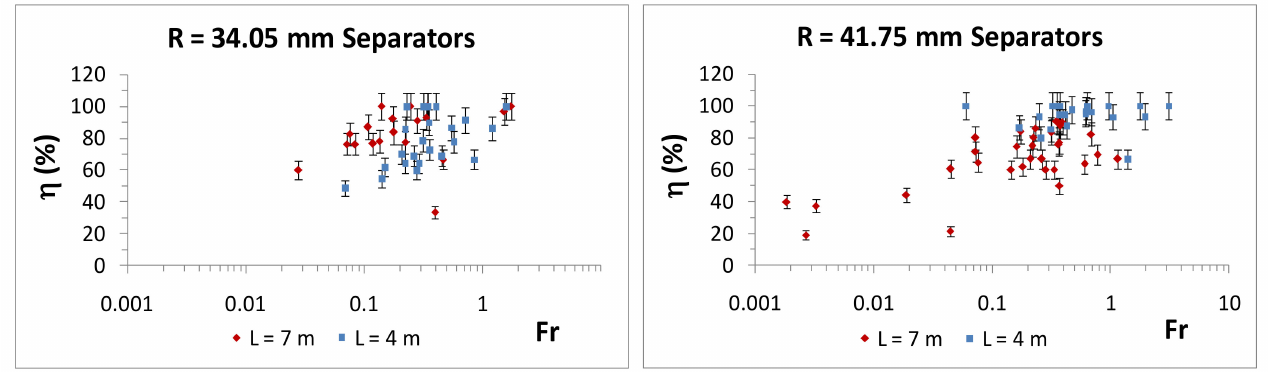
Figure 17. Relationship between Froude number Fr and η (%) for the separators tested with different helix radiuses R (34.05 mm and 41.75 mm) and tube lengths L (4 and 7